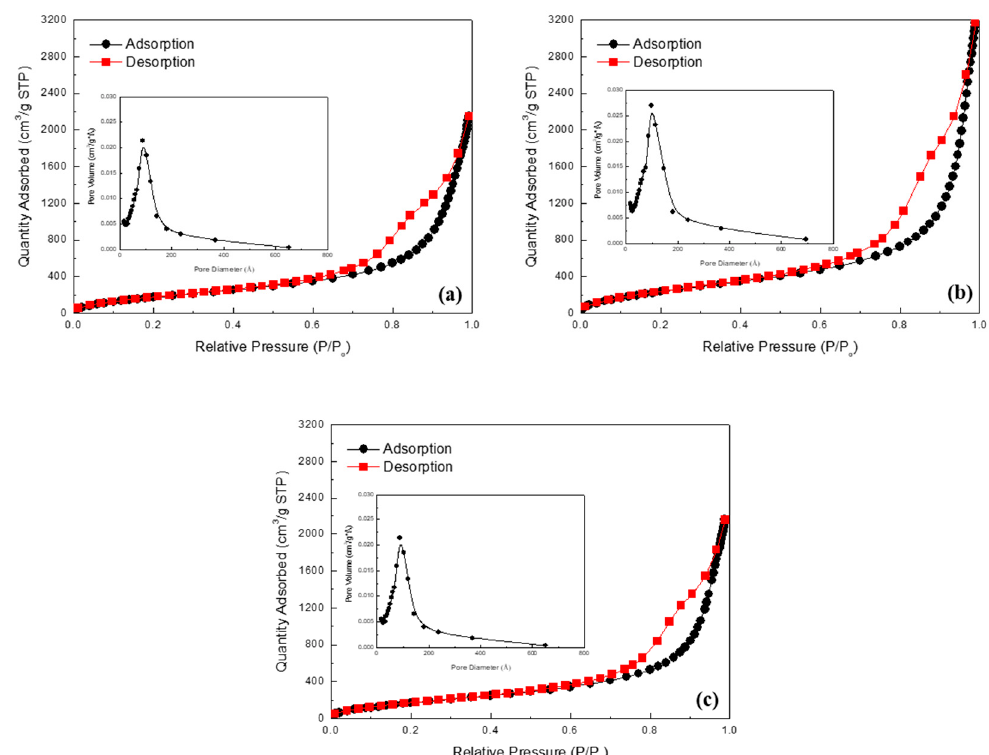
Figure 5. Adsorption–desorption isotherms of spherical silica aerogel powders synthesized from ( a ) 5.3%; ( b ) 6.6%; ( c ) 7.0% water glass solutions. Insets show pore size distribution based on BJH (adsorption).